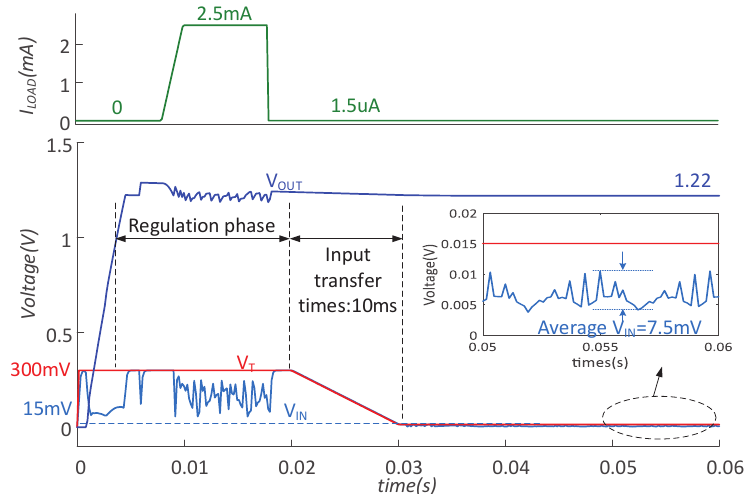
Figure 14. The simulated results with V T from 300 mV to 15 mV.